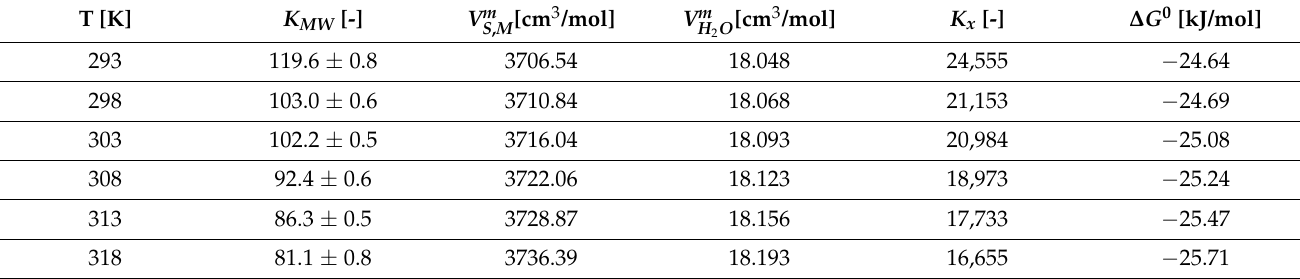
, V m , K x , ∆ G 0 , ∆ H 0 and ∆ S 0 for AuO in ELP S , M H 2 O